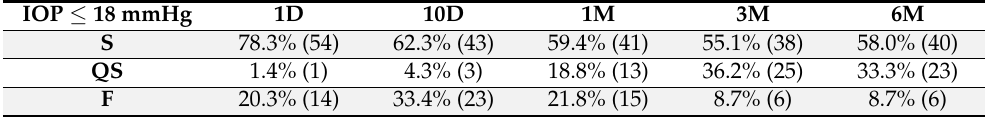
Table 3. Success criteria 2: intraocular pressure lower than 18 mmHg after GATT procedure.